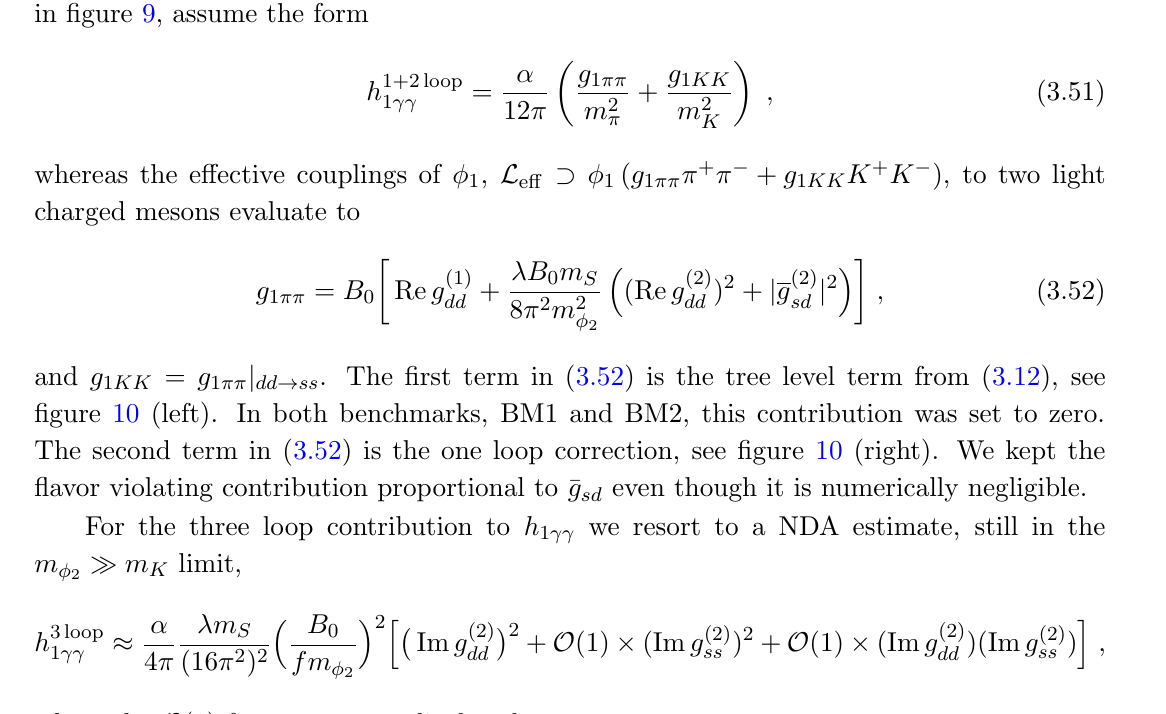
Figure 10 . Tree level and one loop contributions matching onto the e(cid:11)ective couplings g 1 (cid:25)(cid:25) / g 1 KK